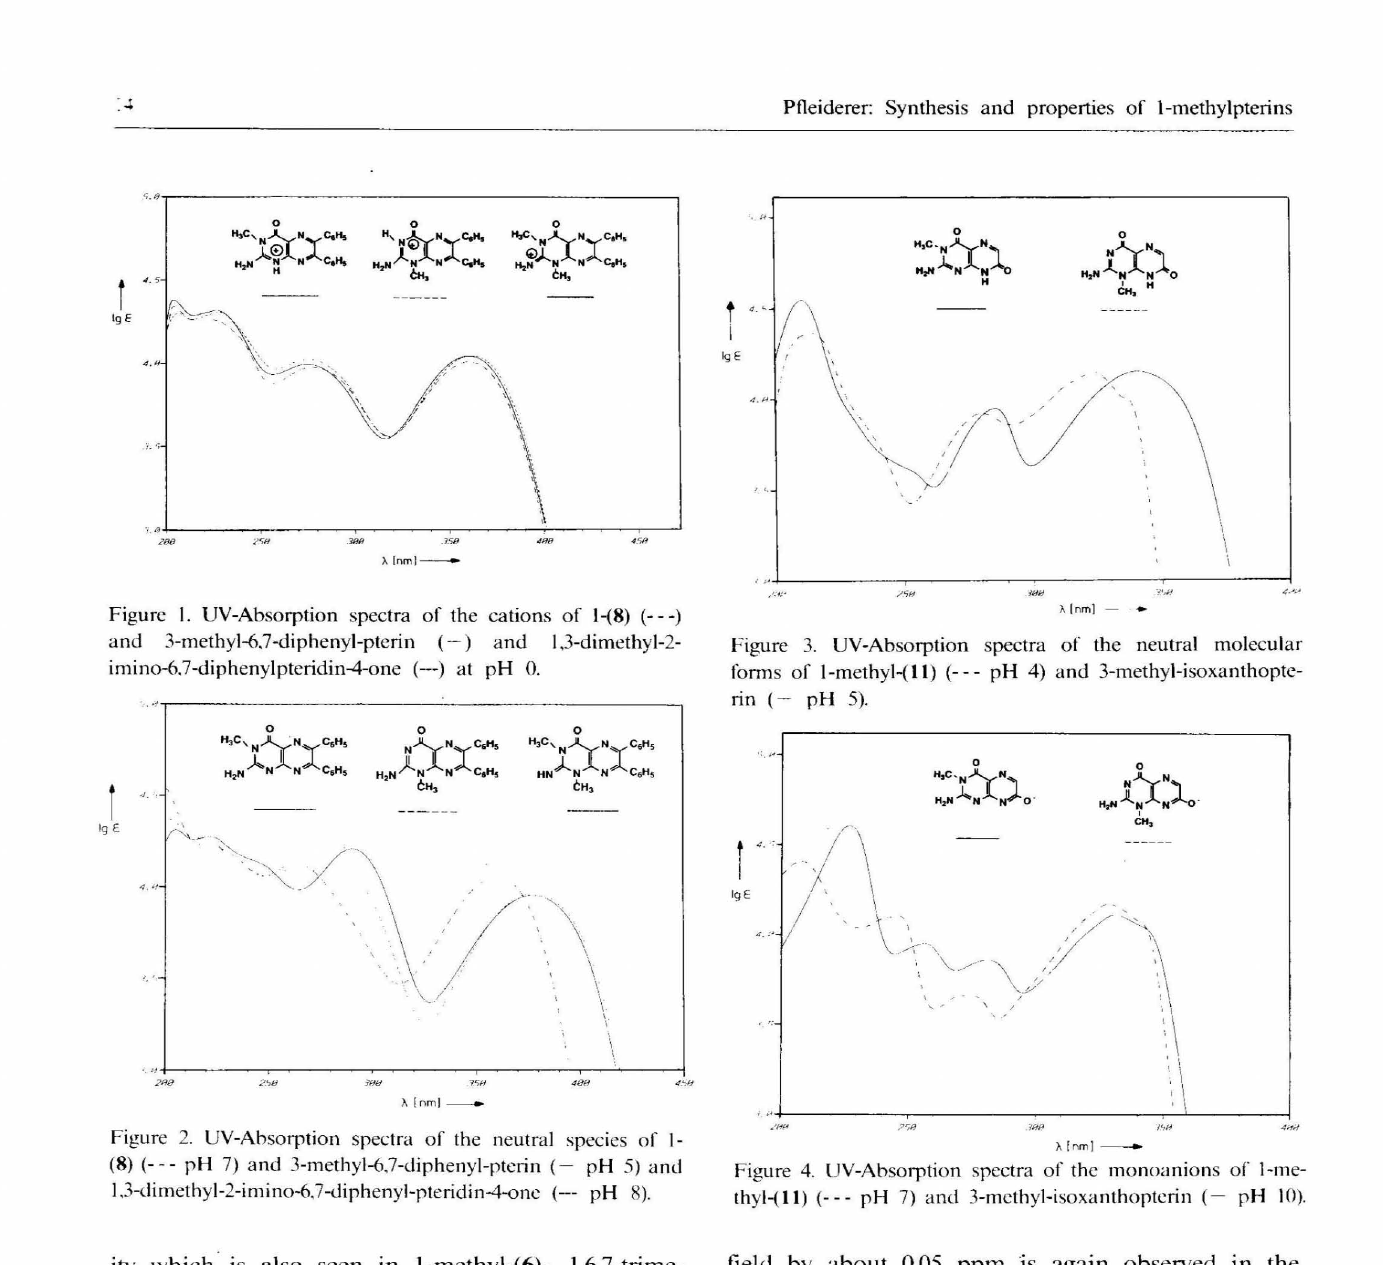
Figure 4. UV-Absorption spectra of the monoanions of I-me thyl-(lI) (--- pH 7) and 3-methyl-isoxanthopterin (- pH 10). field by about 0.05 ppm is again observed in the I-methyl compared to the 3-methyl-pterin